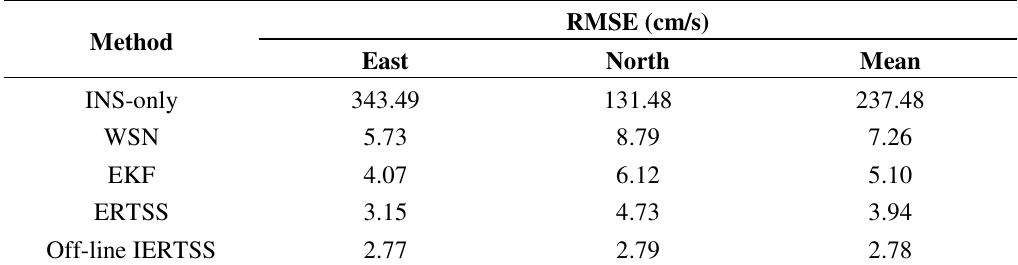
Table 4. Comparison of five estimation strategies in terms of velocity error.